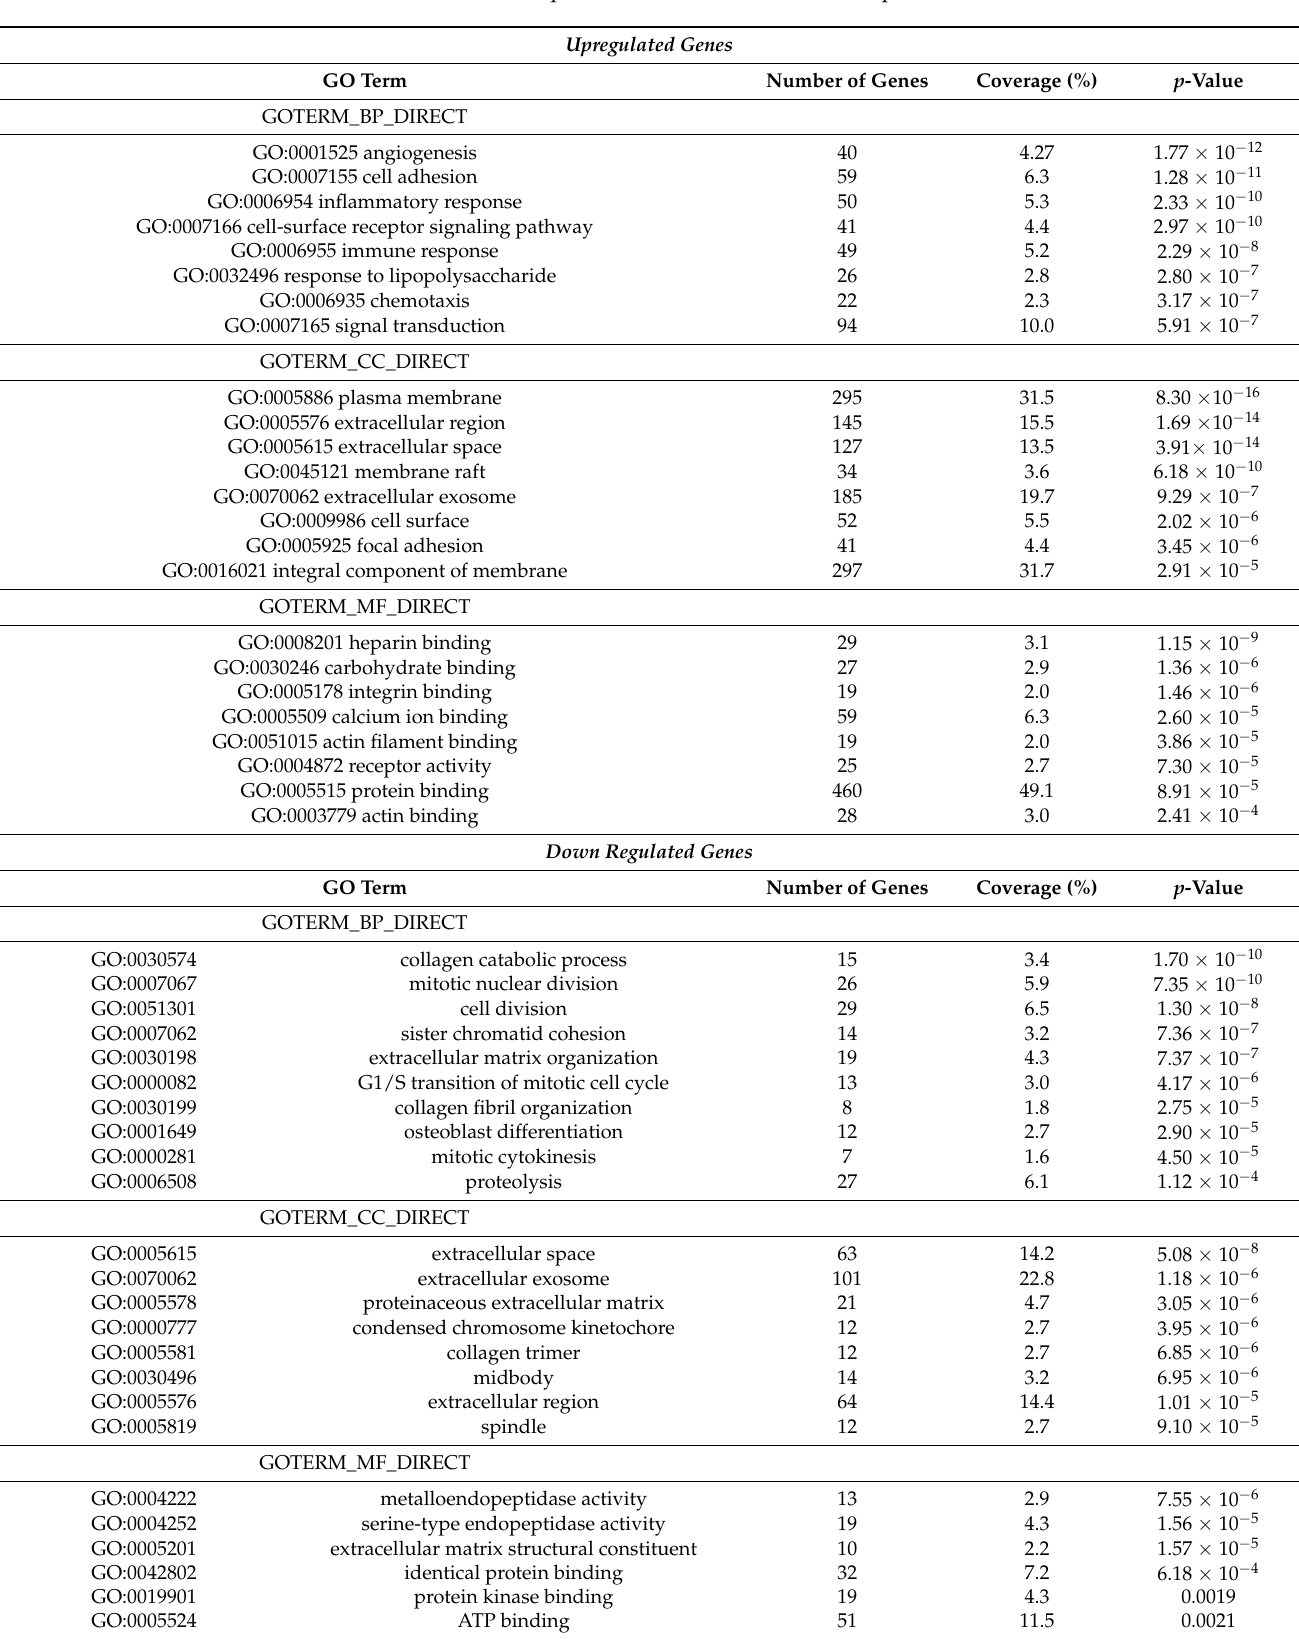
Table 2. The functional enrichment analysis of the DEGs to clarify the gene ontology terms in the NSCLC disease. The top GO terms are summarized and presented